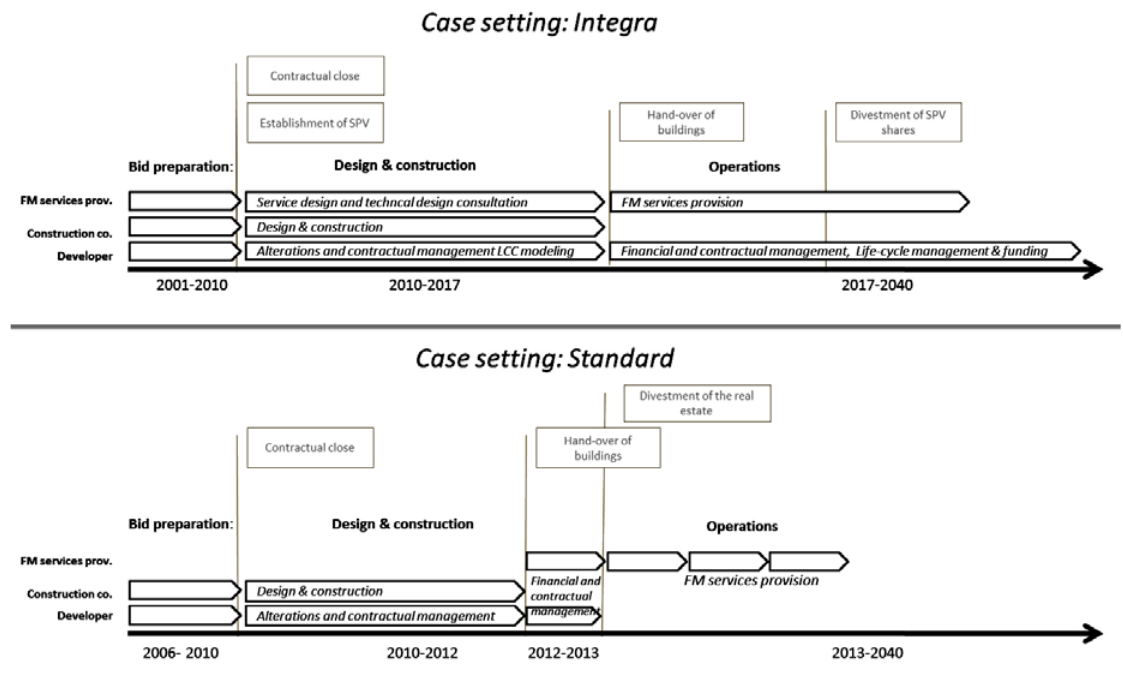
Fig. 1. Key activities of Integra and Standard case